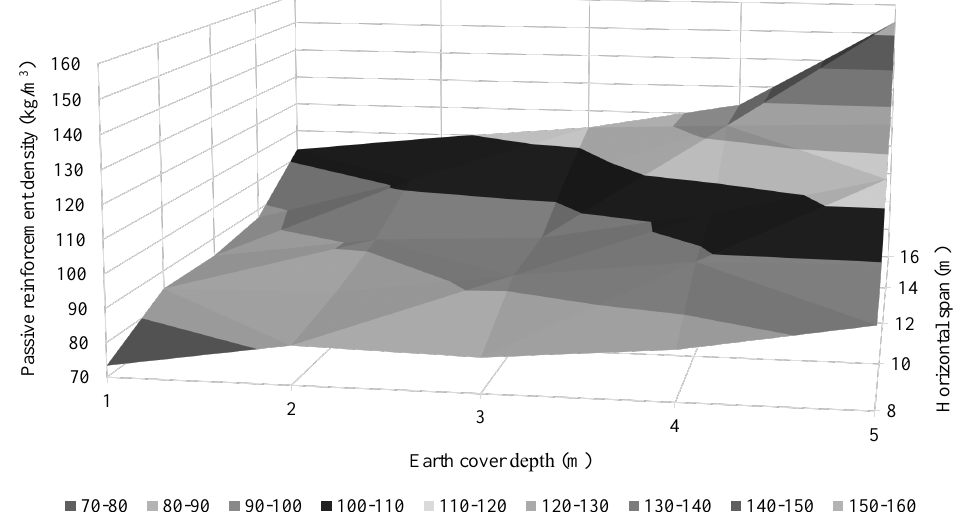
Figure 13. Reinforcement density distribution surface for the optimum RMHFs configurations